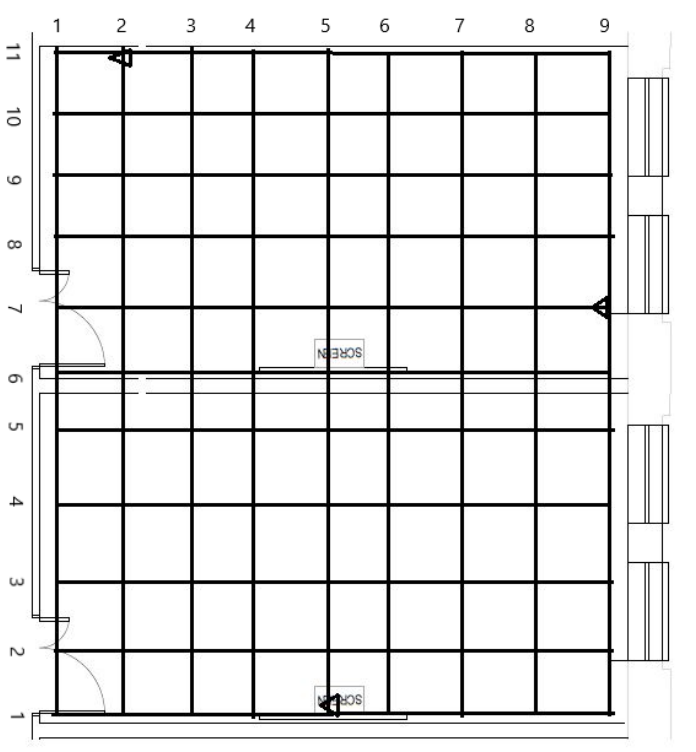
Figure 1. Experimental setting for the